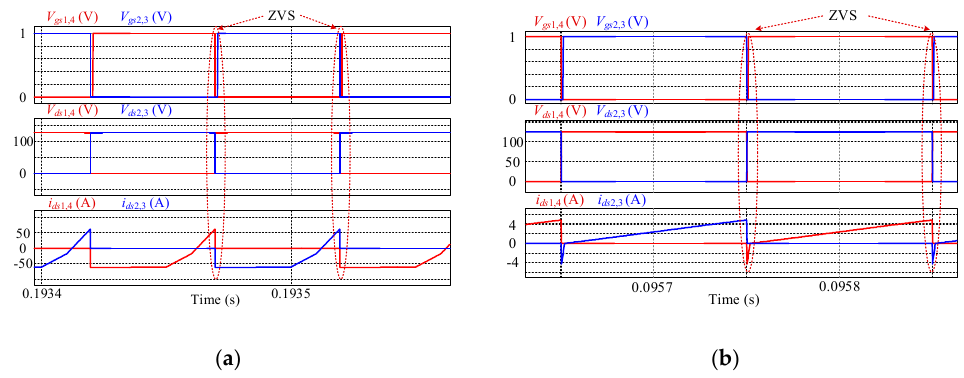
Figure 16. Zero voltage switching (ZVS) of switches in the battery side circuit: ( a ) battery is charged;